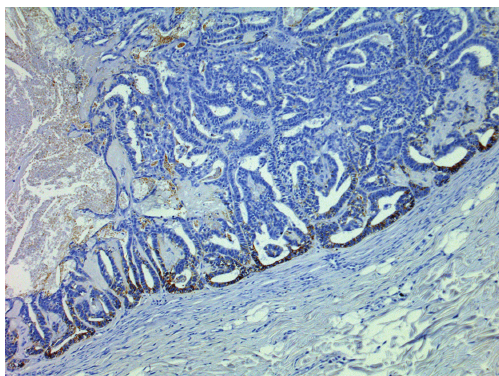
Figure 4: Tubulopapillary carcinoma. Aberrant P-cadherin immu- noreactivity in luminal epithelial cells (membranous and cytoplas- mic) (streptavidin-biotin-peroxidase method, 100x).